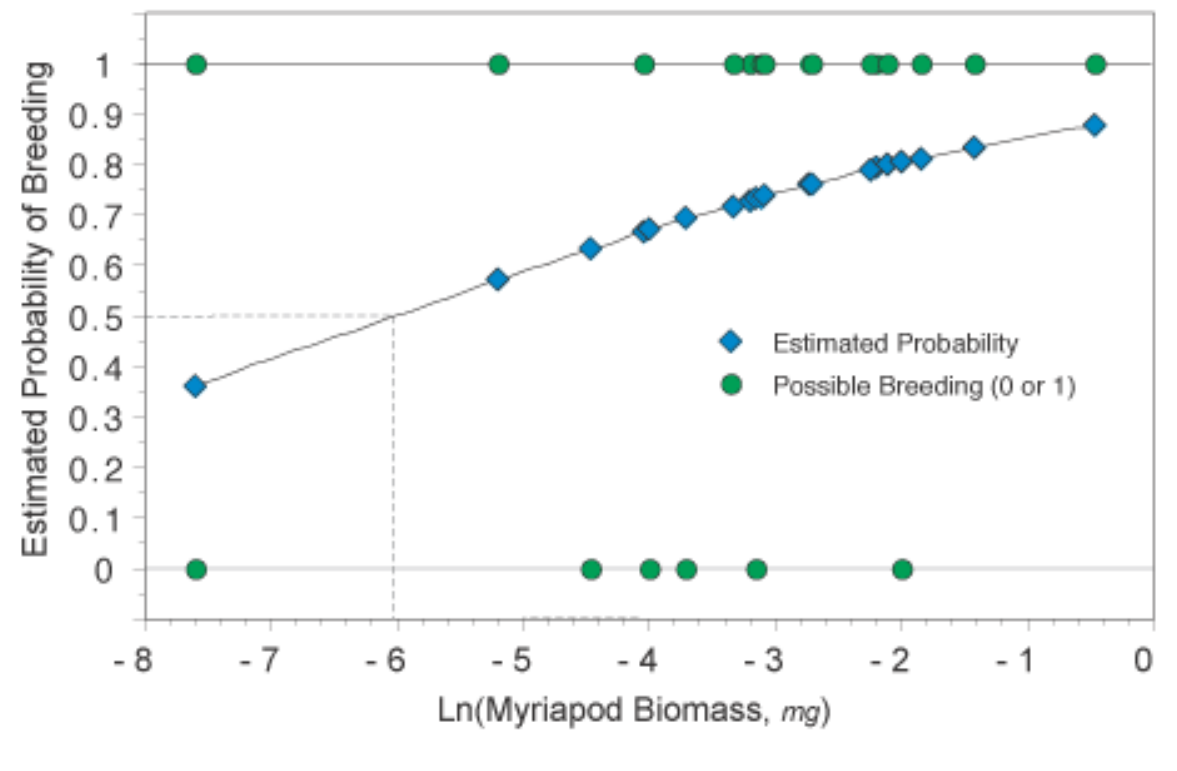
Fig. 7. Logistic regression of the presence of a breeding Wood Thrush on the log-transformed mass of myriapods. The green circles represent the actual presence (1) or absence (0) of a breeding thrush. The blue circles represent the predicted probability of a breeding thrush presence, given the biomass of myriapods. The relationship is significant ( P = 0.0361), and predicts the presence of Wood Thrushes relatively well, correctly classifying 74% sites in which a breeding Wood Thrush was present (Table 2). The dashed line represents the cutoff or threshold value: points above or to the right of the line are predicted presences. The green dot at &#126 -7.5 represents several sites in which no calcium-rich prey were